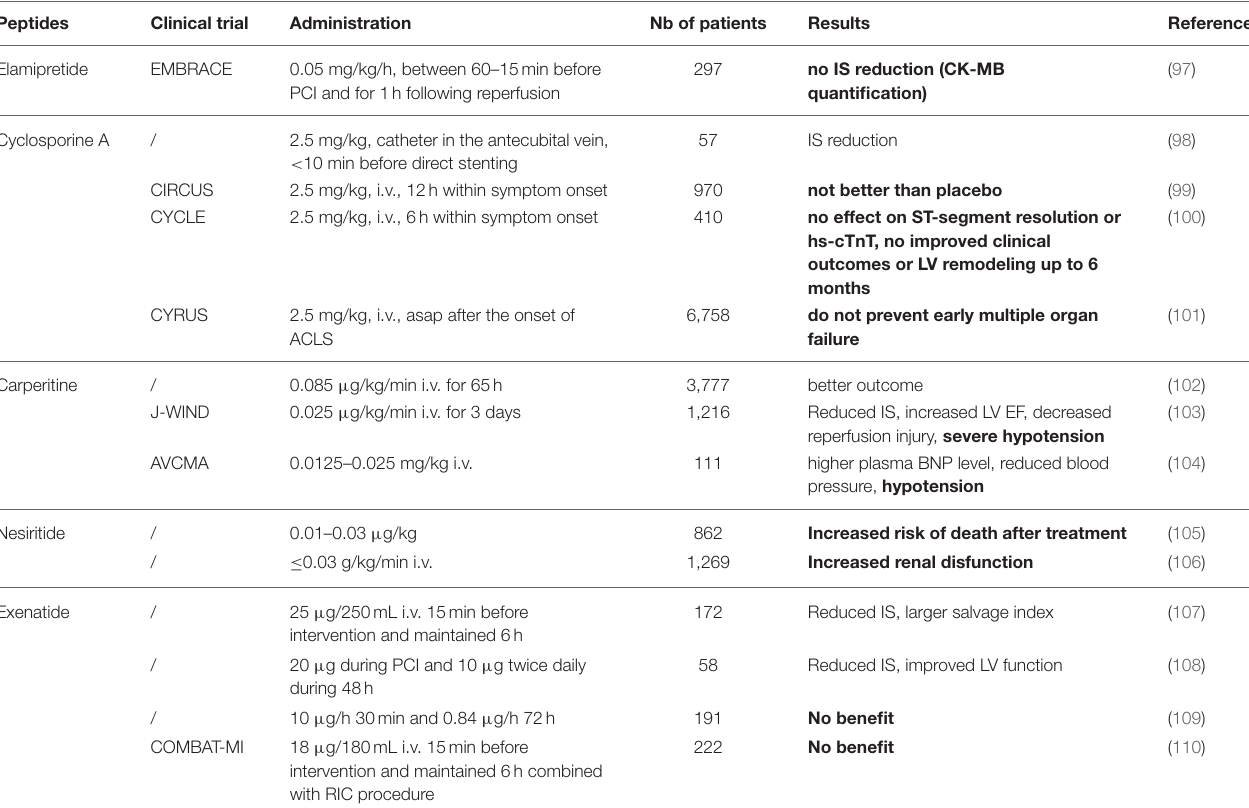
TABLE 2 | Therapeutic peptides used in clinical trials mentioned in this review.